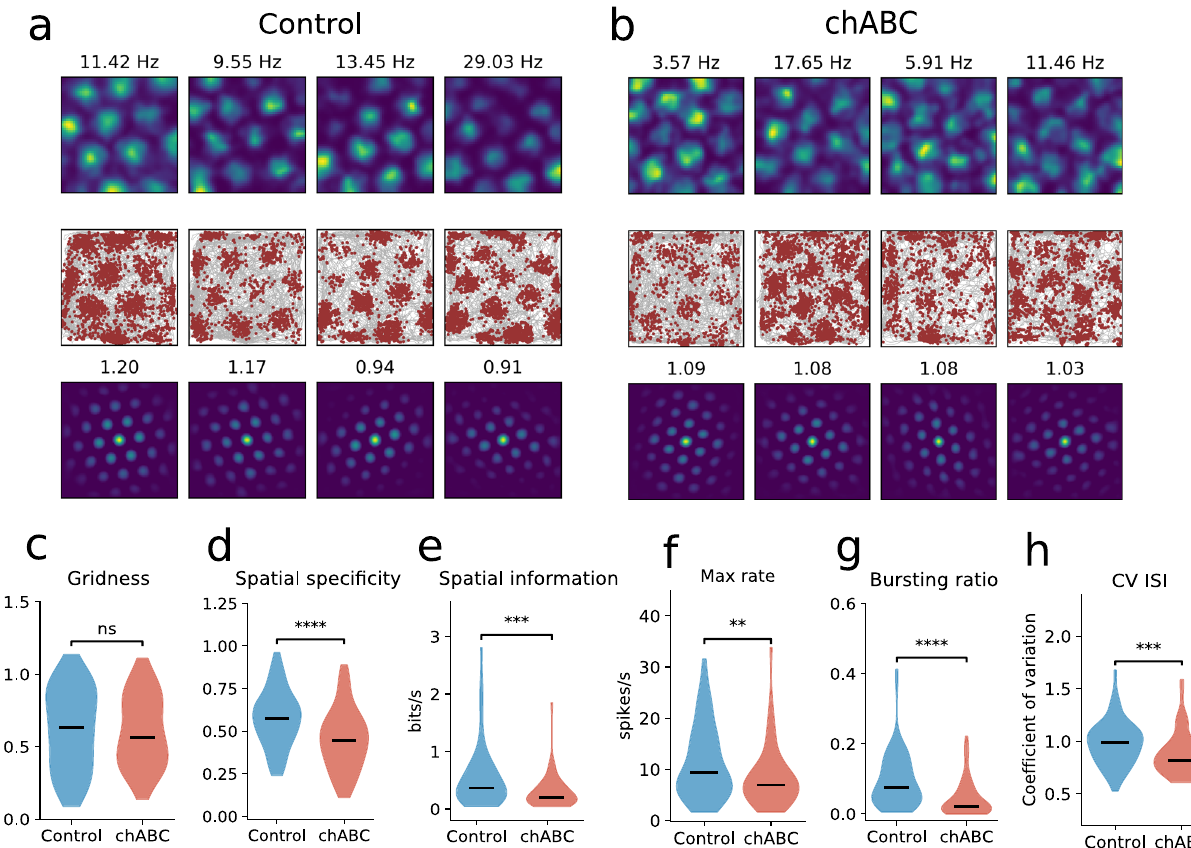
Fig. 2 Grid cells show reduced spatial coding after PNN removal. a , b Example grid cells from control and chABC-treated rats. Color-coded rate maps (top), running path with spikes superimposed (middle) and spatial autocorrelation maps (bottom) for four grid cells in controls ( a ) and four grid cells in chABC-treated rats ( b ). The number above the rate map is maximum fi ring rate and the number above the autocorrelation map is gridness score. c Removing PNNs did not reduce gridness in the familiar environment (median; Control 0.63; chABC 0.56, p = 0.694). d The dispersed spiking outside grid cell fi elds caused the spatial speci fi city of grid cells to decrease (median; Control 0.57; chABC 0.45, p < 0.0001), in addition to reducing the e spatial information (median; Control 0.36; chABC 0.2, p < 0.0001). f Maximum fi ring rate was reduced (median; Control 9.32; chABC 6.93, p = 0.009). g Grid cell bursting ratio was measured as the number of bursting events divided by the number of single-spike events. Rats with disrupted PNNs showed a large reduction in bursting event ratio (median; Control 0.08; chABC 0.02, p < 0.0001). h Spiking variability was measured as the coef fi cient of variation (CV) of interspike intervals (ISI). The method used here calculates CV of ISI using only spikes from passes though grid fi elds (Supplementary Fig. 5) (median; Control 0.99; chABC 0.82, p < 0.001). Violin plots show min to max and median (black line). Width of graph corresponds to number of samples for each value. Control n = 86, chABC n = 63. Mann – Whitney U test (two sided). ** p < 0.01, *** p < 0.001, **** p < 0.0001. Source data are provided as a Source Data fi